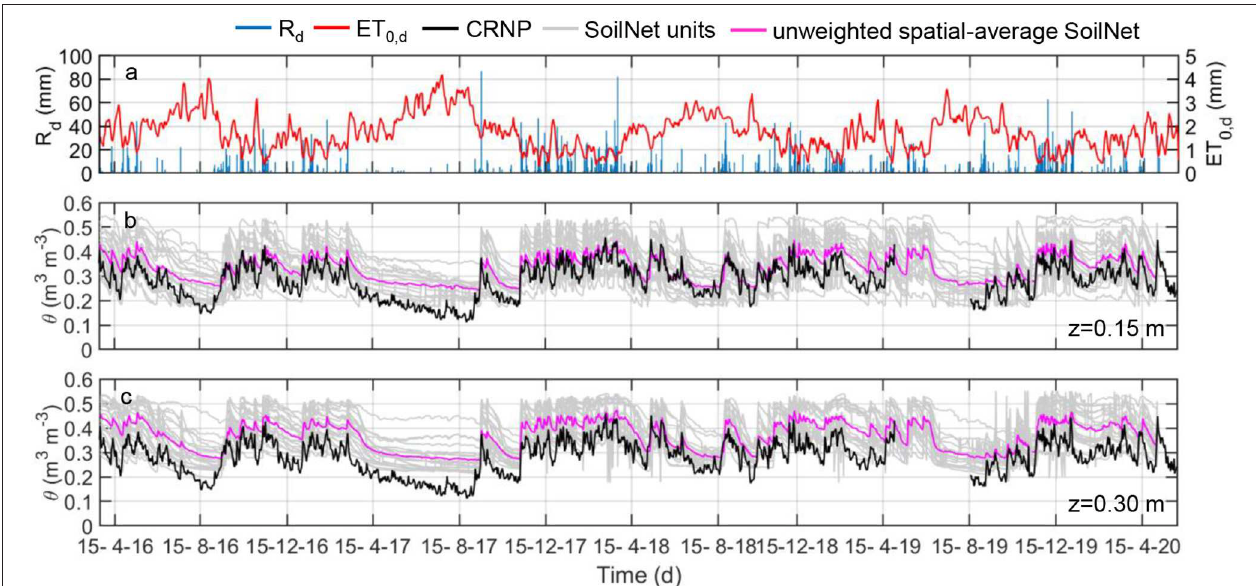
FIGURE 3 | Daily values of (a) rainfall, R d (blue bars), reference evapotranspiration, ET 0, d (red line), (b) SoilNet-based soil moisture contents (gray lines) at 0.15m soil depth at the 20 locations and their unweighted spatial-mean (magenta line) and CRNP-based soil moisture (black line) and (c) SoilNet-based soil moisture contents (gray lines) at 0.30m soil depth at the 20 locations and their unweighted spatial-mean (magenta line) and CRNP-based soil moisture (black line) at MFC2.